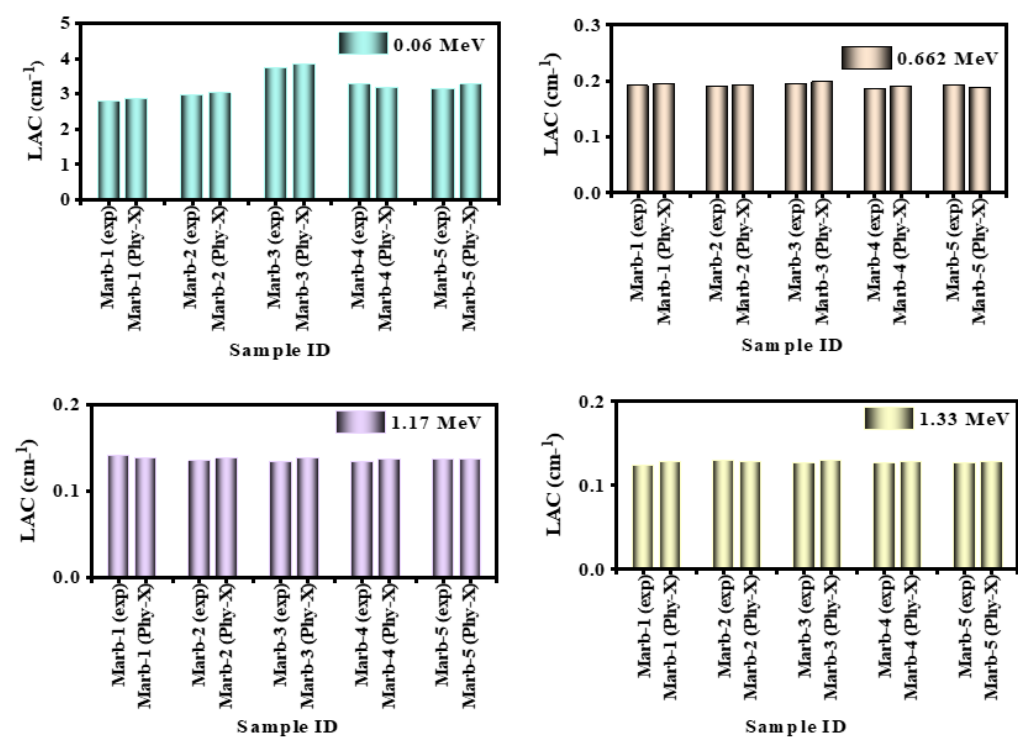
Figure 4. Demonstration of the deviation of the LAC values between the experimental and Phy-X software values. The linear attenuation coefficients ( LAC ) of the prepared composites made up of pol- yester/waste marble/PbCO 3 /CdO at energies 0.015 MeV to 15 MeV were calculated by Phy-X software and the obtained values are presented in Figure 5. Herein, Figure 5 has demonstrated that the value of the linear attenuation coefficients ( LAC ) of the prepared composites declined with the rise in incident gamma radiation energy. Photoelectric ab- sorption (PE) and Compton scattering (CS) can all be used to explain this tendency. It is because the PE mode is dominant at 0.06 MeV, while CS is dominant at the last two ener- gies, 1.173 MeV and 1.333 MeV. The composition of Marb-3 provides better results despite having a similar density due to the k-edge effect of both Cd and Pb together. In the first compositions (Marb-1 and Marb-2) the concentration of Cd decreases, while in the latter compositions (Marb-4 and Marb-5) the concentration of Pb decreases.